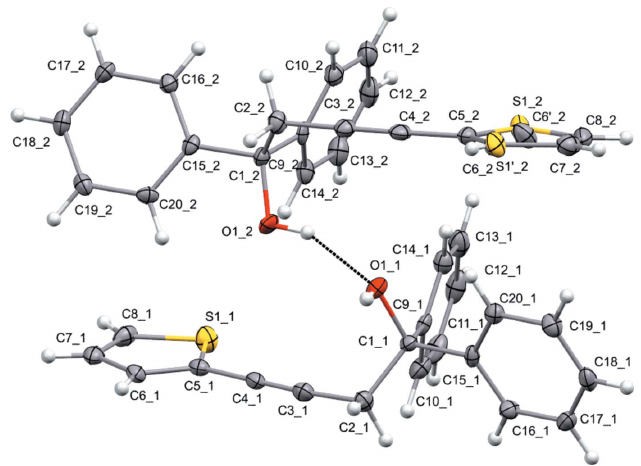
Figure 1 The title molecules with 50% probability ellipsoids. The intermolecular O—H (cid:2)(cid:2)(cid:2) O hydrogen bond is shown as a black dotted